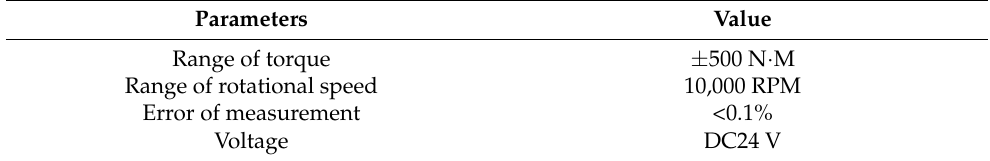
Table 1. Main parameters of the sensor.